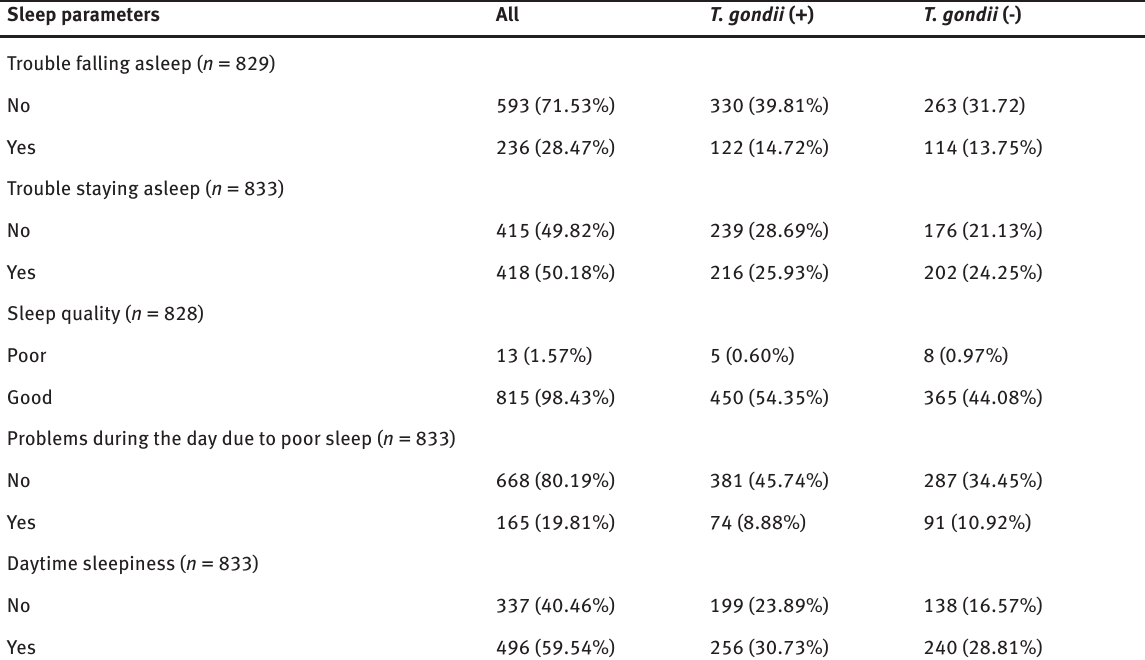
Table 1 : Sleep parameters and T. gondii seropositive/seronegative status. Sleep parameters All T. gondii (+) T. gondii (-) Trouble falling asleep ( n =